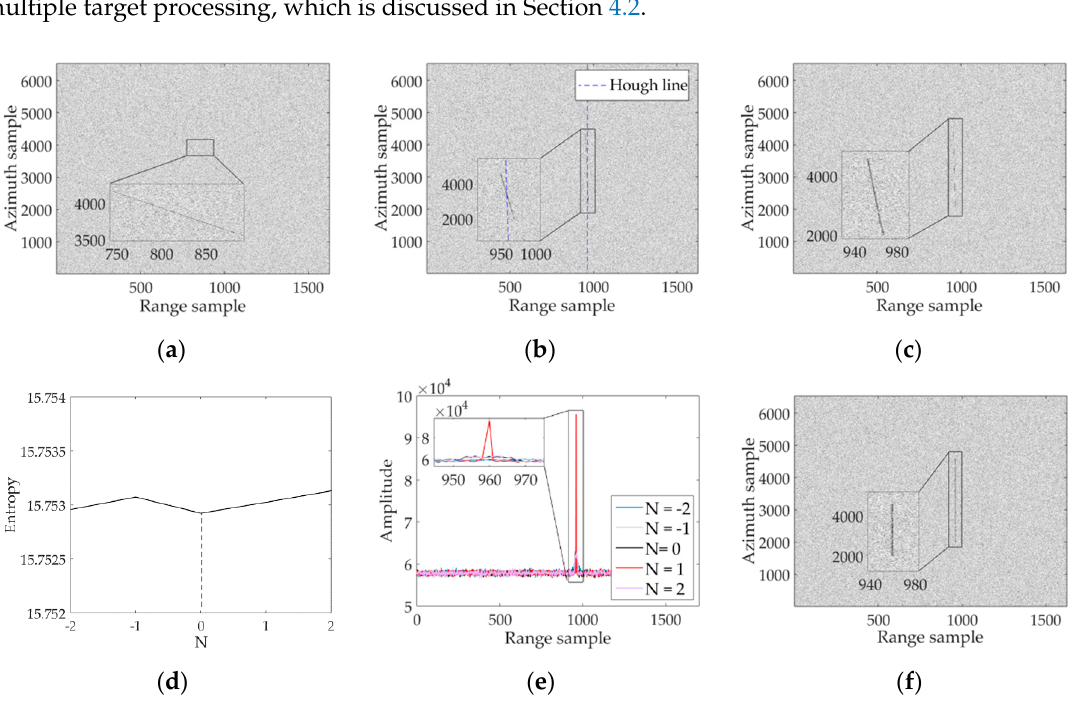
Figure 8. Simulation results for Hough transform, KT and BM-KT: ( a ) range compressed signal; ( b ) pre-processing and Hough transform result; ( c ) KT result; ( d ) image entropy result for each N ; ( e ) blur matched result for each N ; and ( f ) BM-KT result.